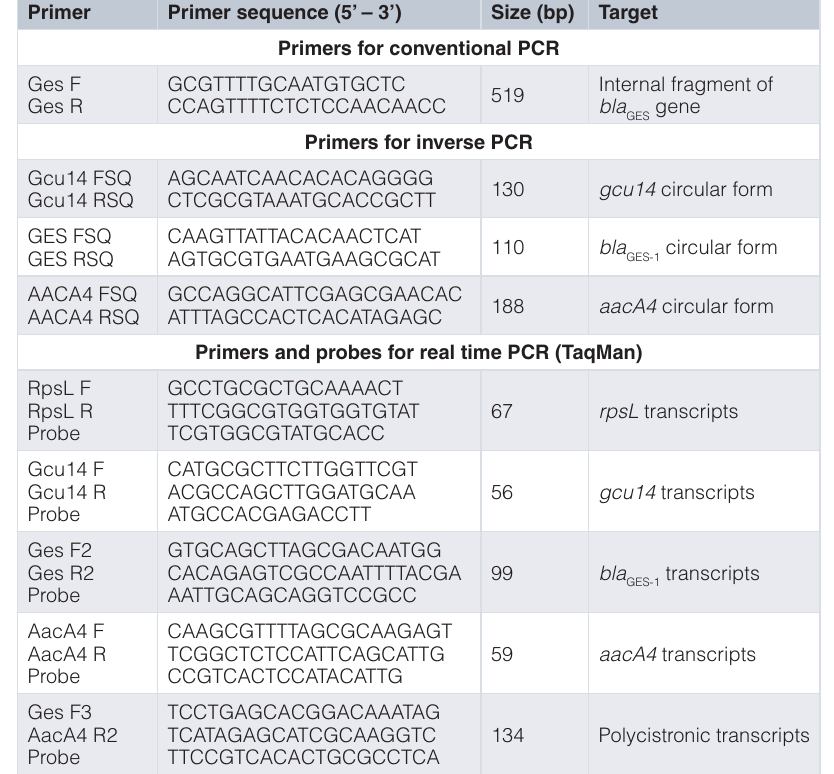
Table 1. Primers used in conventional, inverse and real-time PCR